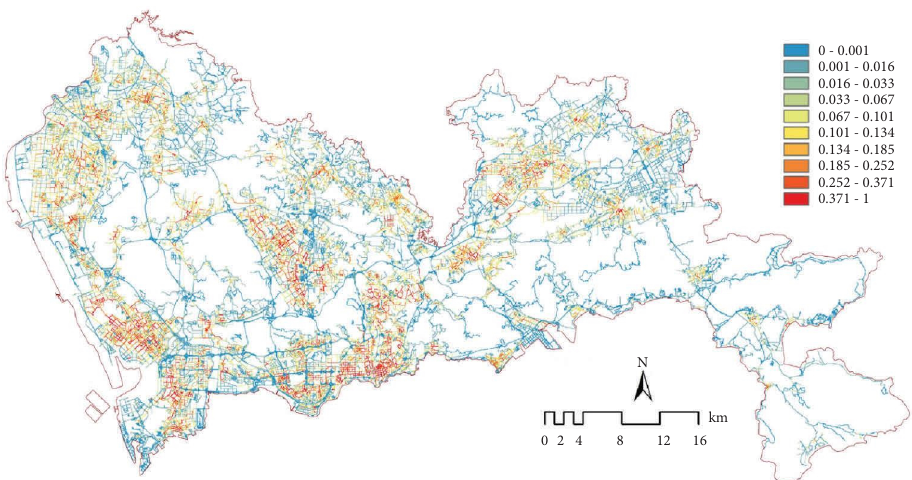
Figure 6: POI density of Shenzhen.